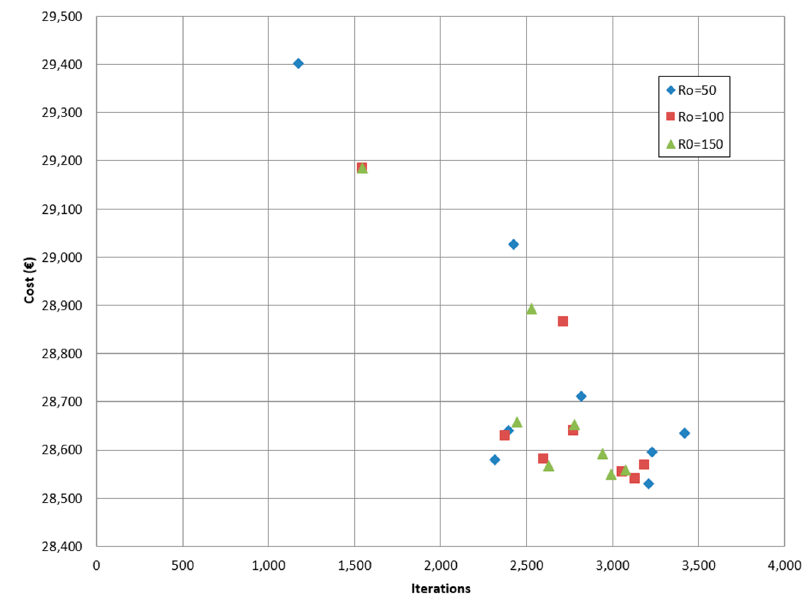
Figure 7. Average cost to average iterations for GSO and DLS combination experiment.